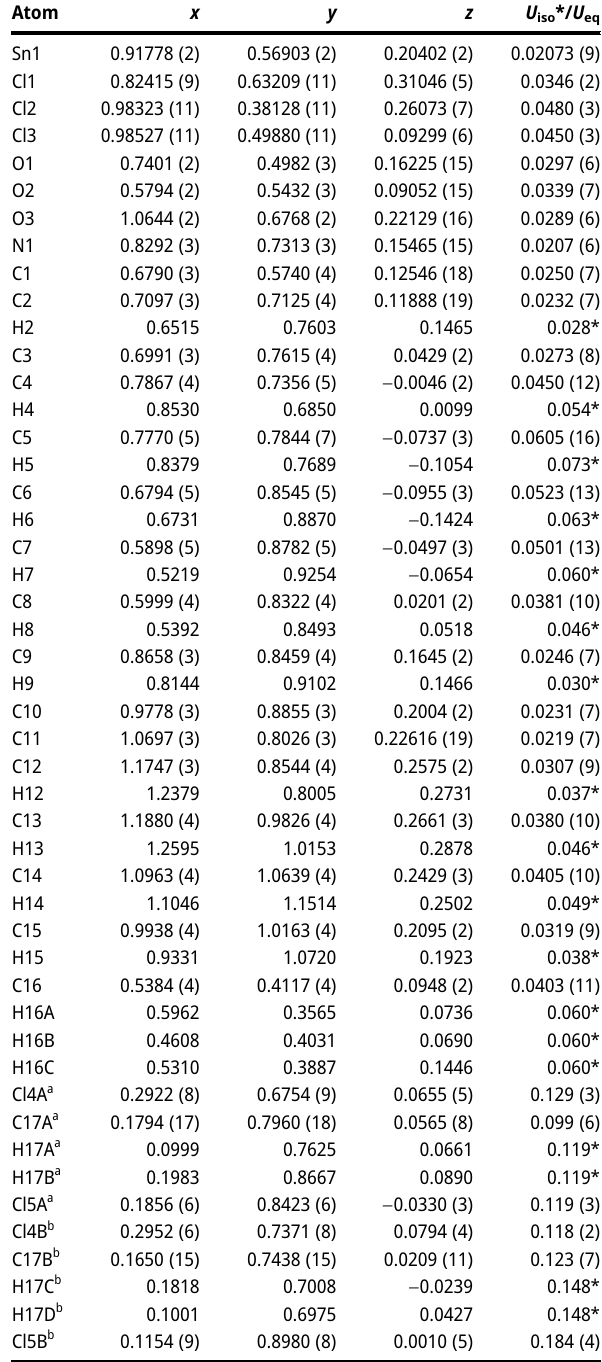
Table  : Fractional atomic coordinates and isotropic or equivalent isotropic displacement parameters (Å 